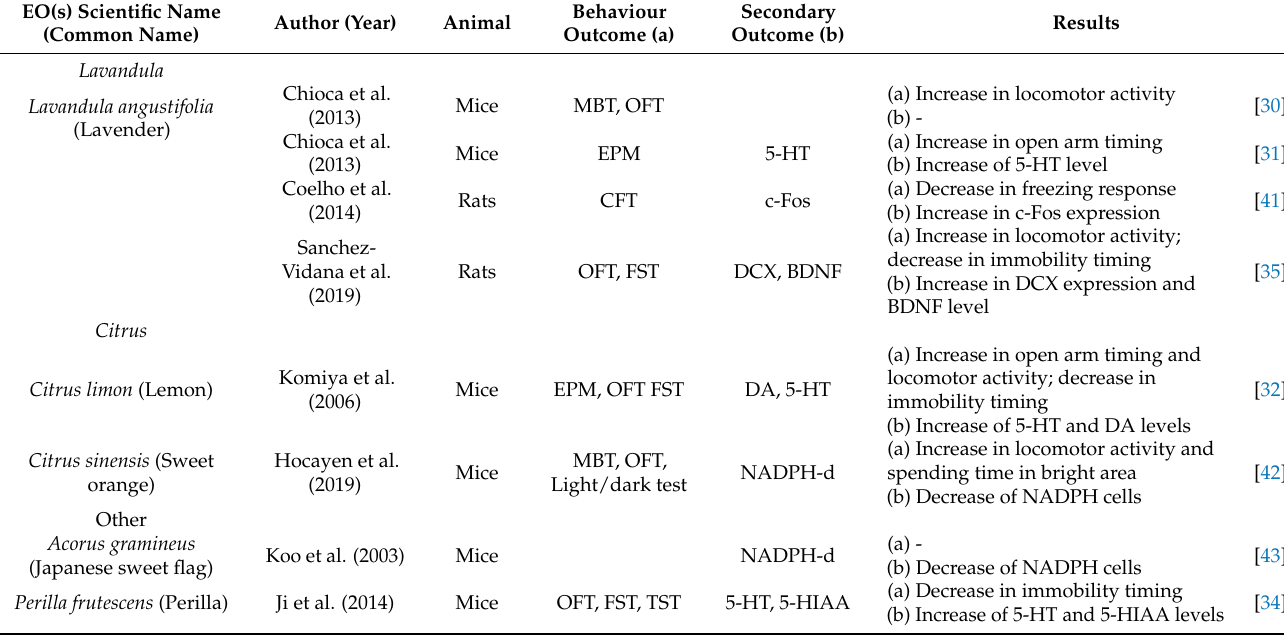
Table 2. Summary of pre-clinical examinations of EO inhalation on depression and anxiety-like symptoms in animal models. EO(s) Scientific Name (Common